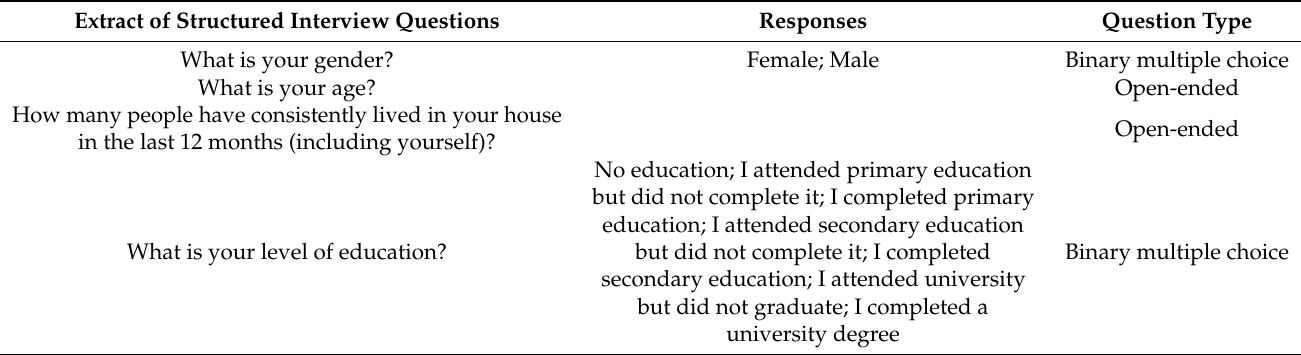
Table A1. Extract of structured interview